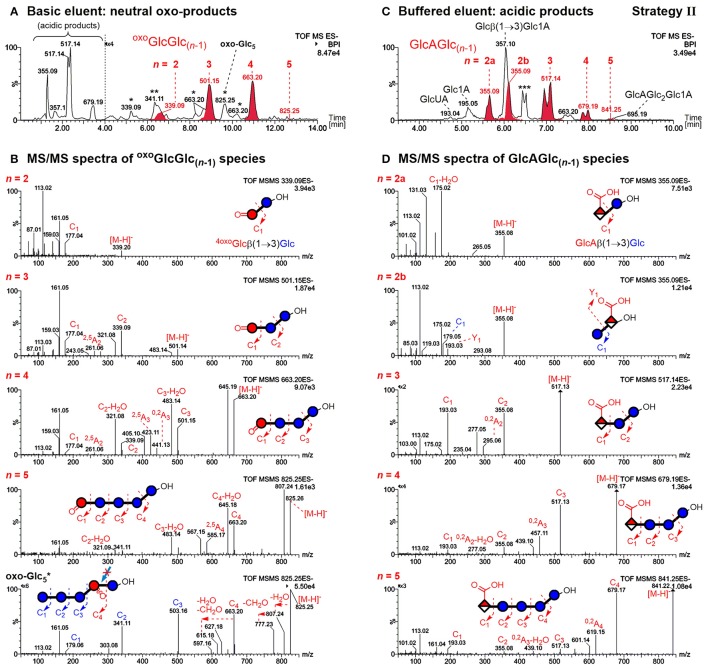
UPLC-MS/MS results in the negative mode using a BEH amide column and ACN/H2O gradient for analysis of barley β-glucan (BBG) oxidation products (harsh conditions) after enzymatic digestion and SPE (strategy II). (A) Analysis of the neutral products using basic 0.1% NH3 eluent additive (oxo-product peaks with carbonyl group at the non-reducing end oxoGlcGlc(n−1) in red) and (B) their respective MS/MS spectra. The main oxo-Glc5 species with C=O at a different position is also included (bottom spectrum). (C) Analysis of acidic products using a buffered 60 mM ammonium formate eluent additive (pH ~ 8) with glucuronic acid bearing oligomers GlcAGlc(n−1) in red. (D) Respective MS/MS spectra of acidic products. The MS/MS fragments are named according to the nomenclature of Domon and Costello (1988) (cleaved linkage: Ci fragments; cross-ring cleavage: Ai fragments; i = 1, 2, … n). *oxo-products with oxidized carbonyl group not at the non-reducing end; **Disaccharide signal from catalase material; ***Buffer salt/solvent peak.